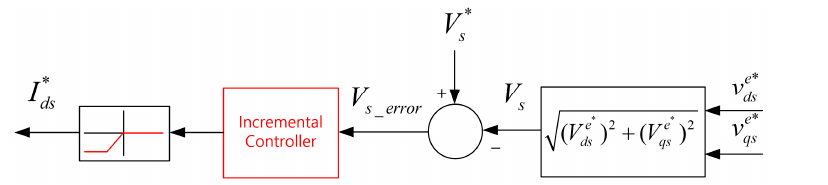
Figure 2. Block diagram of voltage-based flux-weakening control when using an incremental controller. Figure 3 illustrates the algorithm flow chart of proposed variable incremental controller.